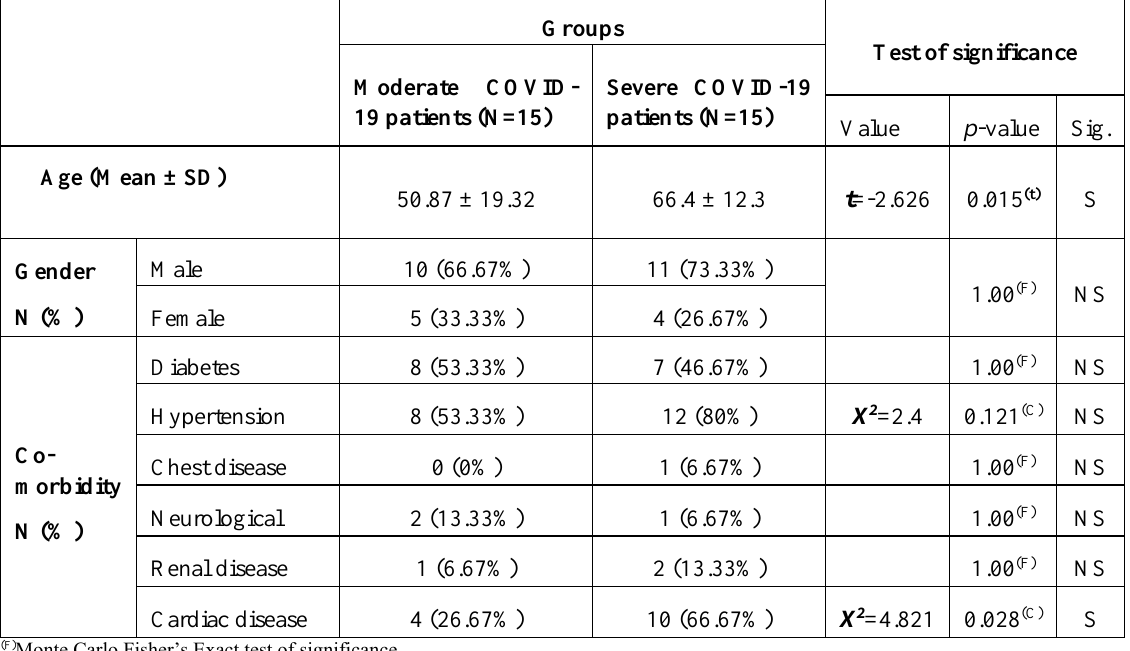
Table 1. Demographic characteristics and co-morbidities among the studied COVID-19 patients.